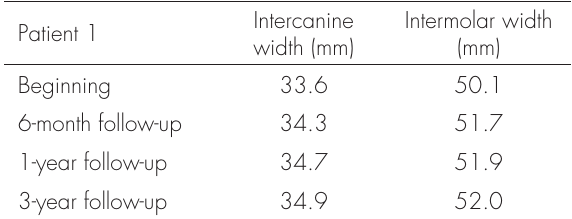
Table I. Study model measurements of the intercanine and intermolar widths in Patient 1.